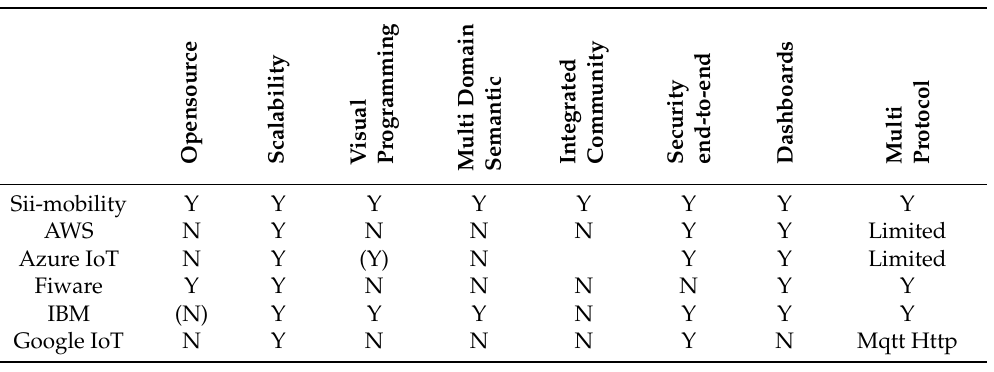
Table 1. Comparation of our IoT platform with the more prominent one (bracket symbols mean partially